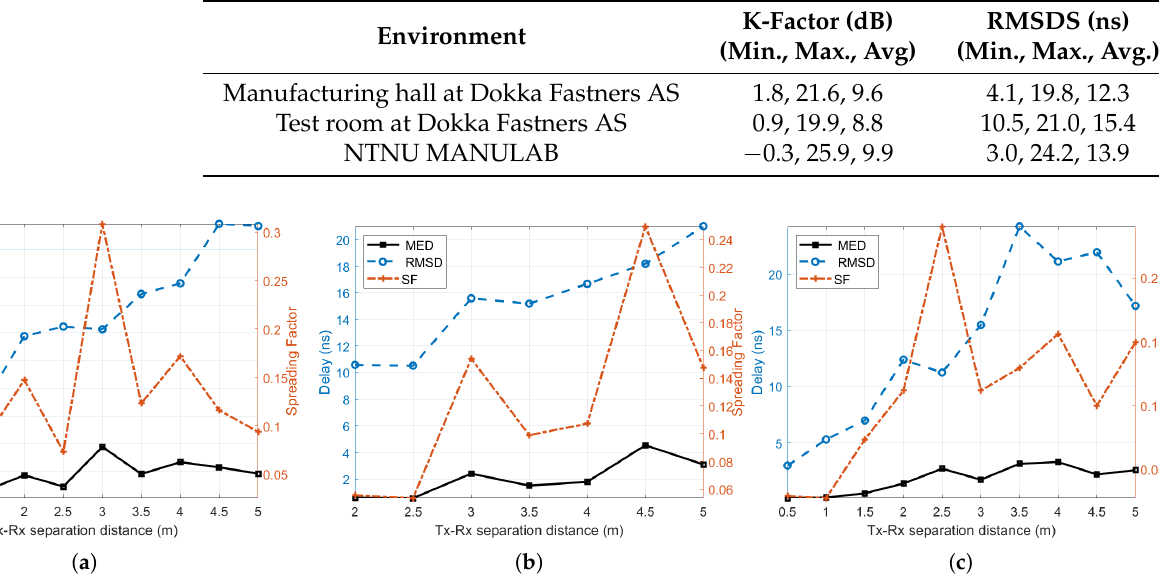
Figure 10. Time dispersion parameters in ( a ) the Manufacturing hall at Dokka Fastners AS, ( b ) the Test room at Dokka Fastners AS, and ( c ) NTNU MANULAB. MED, mean excess